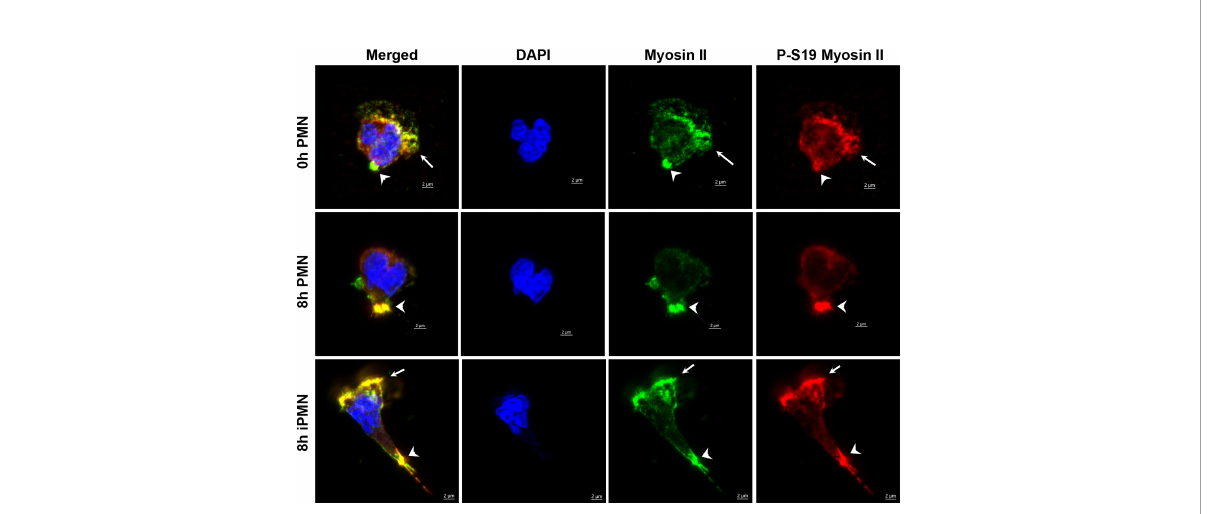
FIGURE 9 Subcellular localization of total and active myosin IIA phosphorylated on S19. Neutrophils were processed for confocal microscopy at 0 or 8 hours after isolation or 8 hours after infection with H. pylori . Representative Z-stack images were stained with DAPI to detect DNA (blue), myosin IIA (green) or S-19-phosphorylated myosin IIA (red). Arrowheads indicate colocalization and enrichment of total and S19-phosphorylated myosin IIA at the uropod. Arrows indicate colocalization and enrichment of total and S19-phosphorylated myosin IIA at the leading edge of cells infected with H. pylori